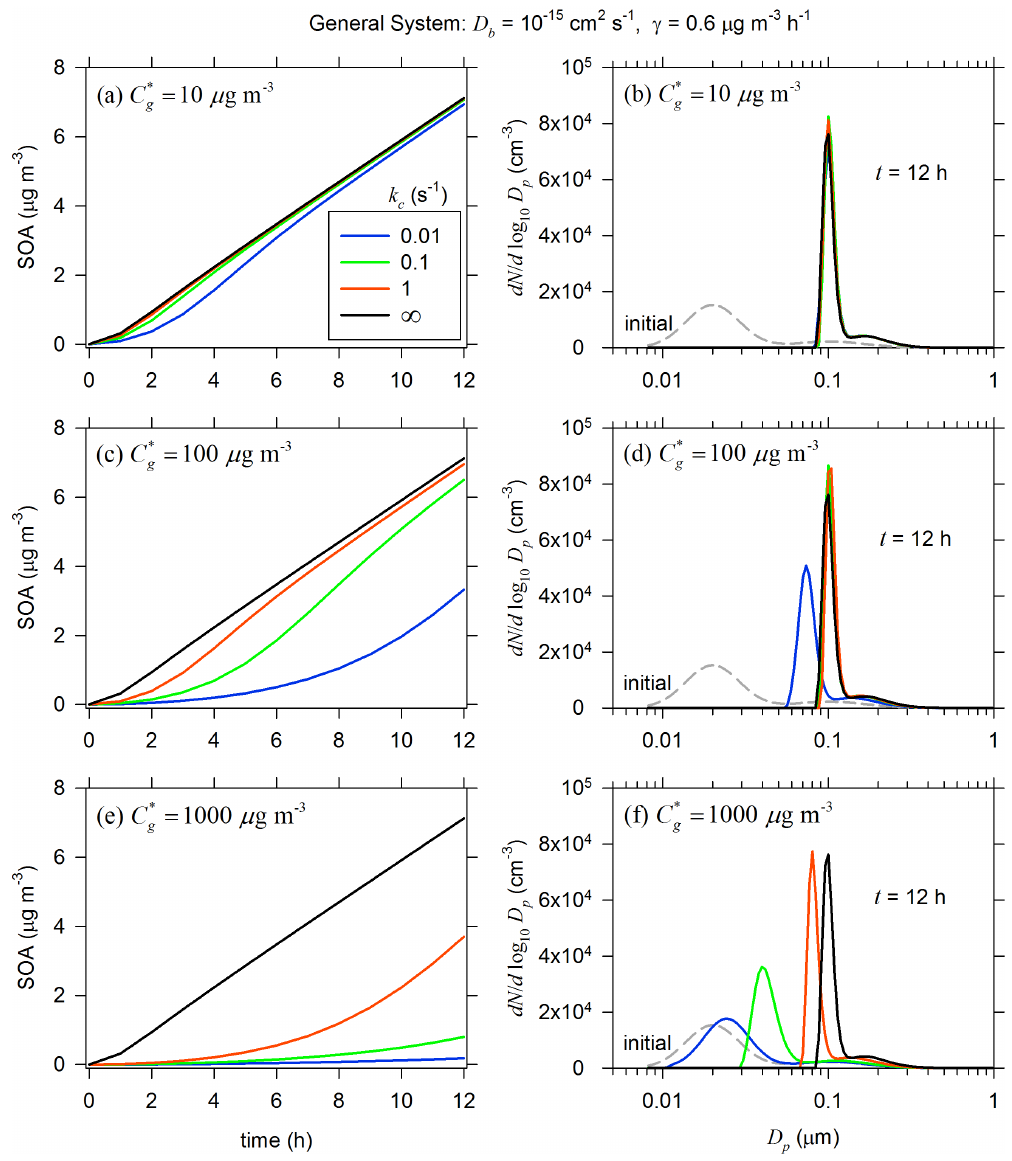
Figure 19. Same as Fig. 18, except D b = 10 − 15 cm 2 s − 1